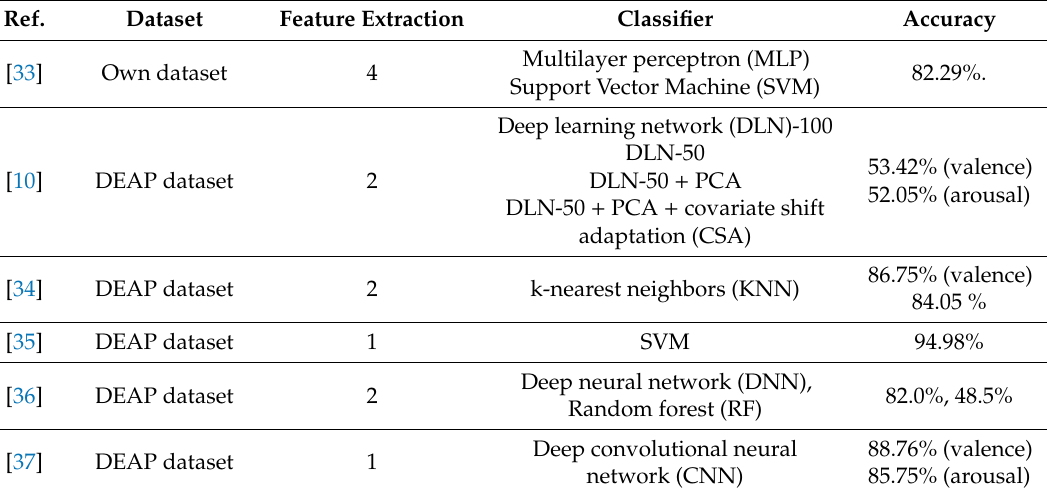
Table 1. Comparison of di ff erent conventional studies on electroencephalogram (EEG)-based emotion